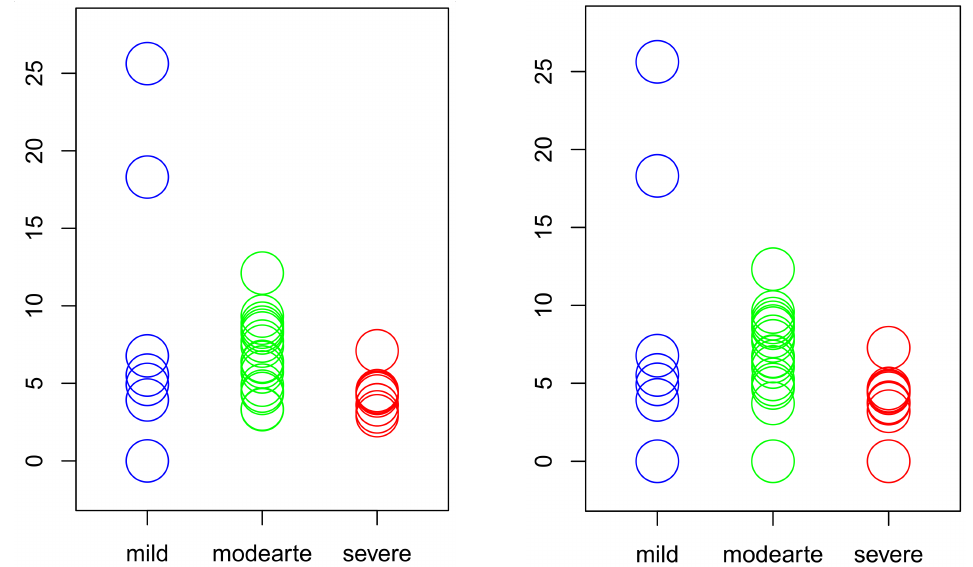
Figure 5. Representation of the I M depth value for the 35 Alzheimer’s patients computed with respect to the center of symmetry of the complete sample ( left plot ) and of the three subsamples separately ( right plot